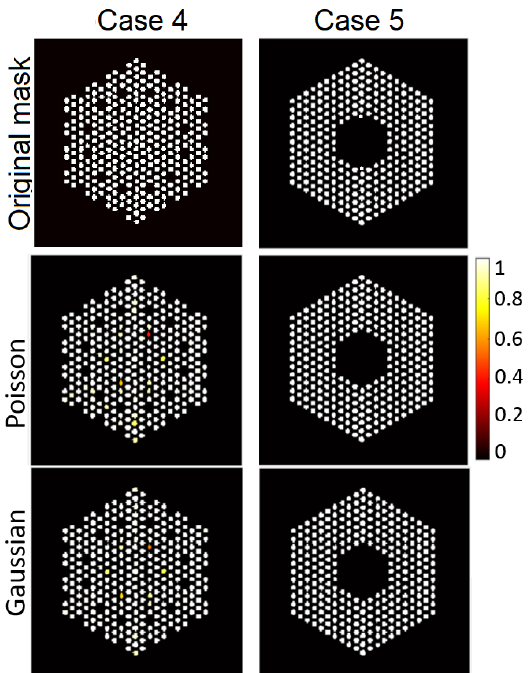
Figure 22. The EMPIRICAL response matrix: probability of presence of pins using the proposed approach. ( Left ): Case “4”; ( right ): Case “5”.